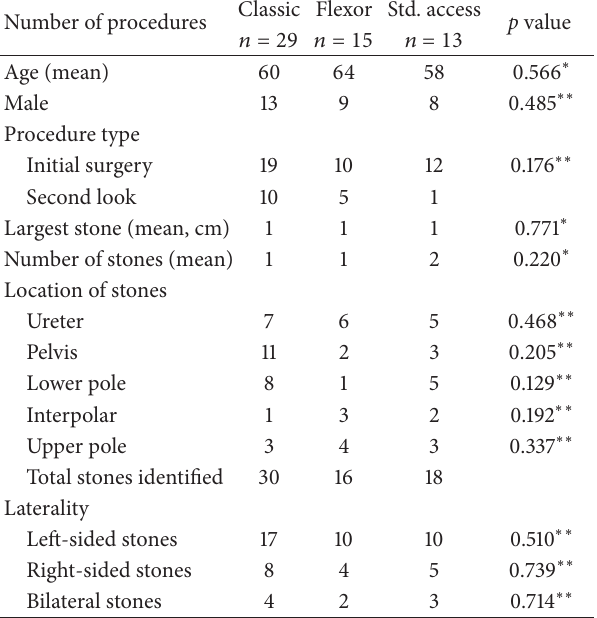
Table 2: Baseline characteristics for three instrumentation